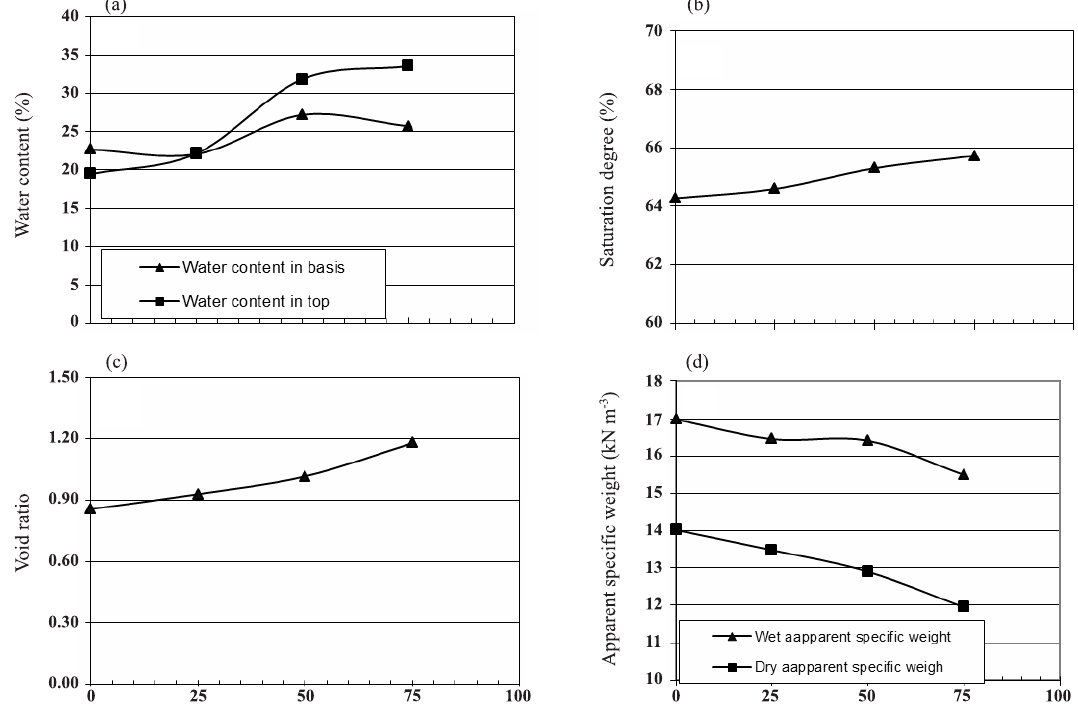
Figure 4. Physical indices of natural soil and soil-sludge mixture (a) Water ratio; (b) Saturation degree; (c) Void ratio; (d) Apparent specific